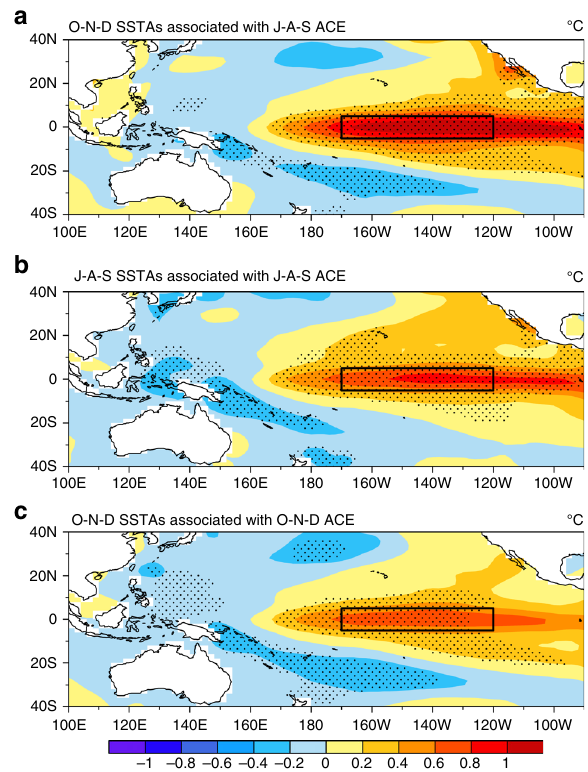
Fig. 2 Tropical Paci fi c sea-surface temperature (SST) anomalies (°C) associated with the accumulated cyclone energy (ACE) anomalies over the western North Paci fi c (10° – 20°N, 135° – 170°E; WNP) in the period 1970 – 2016. a Composite of the O – N – D (each month from October to